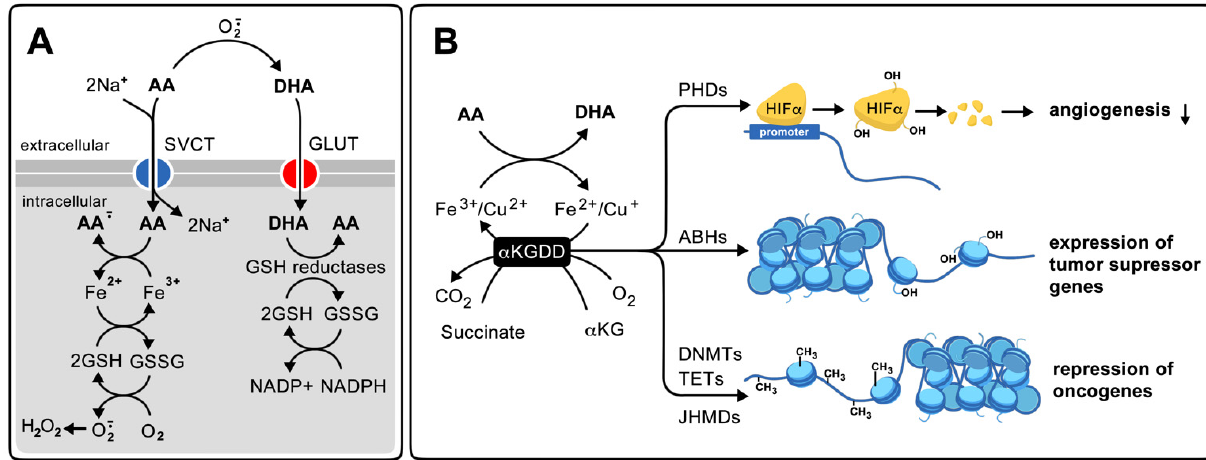
Figure 3. Proposed mechanisms of anti-cancer action of high doses of vitamin C. ( A ): Pro-oxidant; ( B ) regulator of gene expression. DHA: dehydroascorbic acid, AA: ascorbic acid, SVCT: sodium-vitamin c transporter, GLUT: glucose transporter, GSH: reduced glutathione, GSSG: oxidized glutathione, NADP: oxidized nicotinamide dinucleotide phosphate, NADPH: reduced nicotinamide dinucleotide phosphate, α KGDD: α -ketoglutarate-dependent Fe 2+ dioxygenase enzymes, α KG: α -ketoglutarate, PHD: hypoxia inducible transcription factor alpha prolyl hydroxylases, HIF α : hypoxia inducible transcription factor alpha, ABH: histone Alpha/Beta hydrolase, DNMTs: DNA methytransferases, TET: ten-eleven translocases DNA demethylases, JHMDs: histone demethylases with Jumonji domain. Translated and modified from Villagran et al. [9].